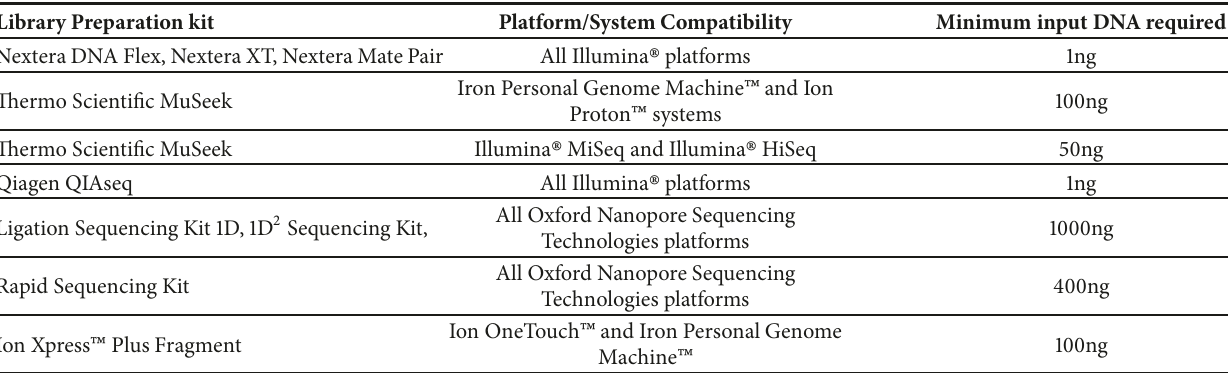
Table 1: Available library preparation kits, compatible platforms, and minimum input DNA required. Library Preparation